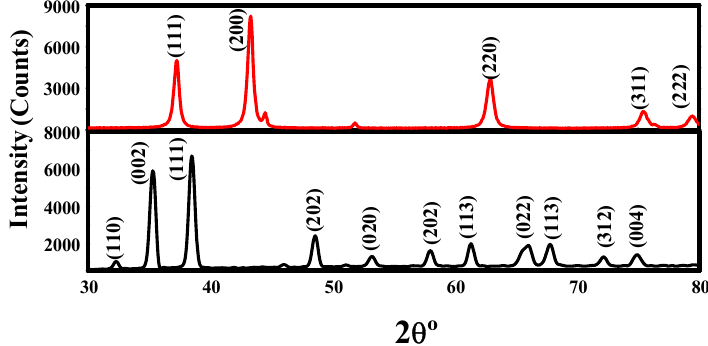
Figure 3. X-ray diffraction (XRD) patterns of the CuO (black) and NiO (red) nanoparticles.